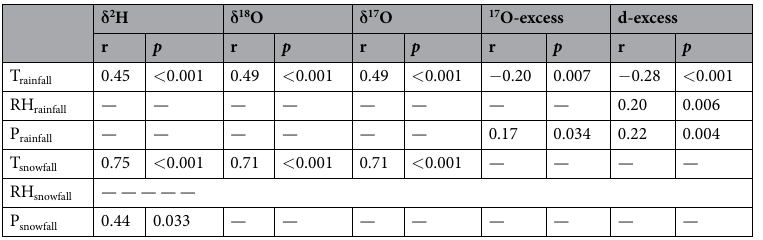
Table 5. The relationships between the precipitation isotopes ( δ 2 H/ δ 18 O/ δ 17 O), 17 O-excess, d-excess and local meteorological parameters (temperature (T), relative humidity (RH) and precipitation amount (P)) for rainfall and snowfall over the study period. “ − ” indicates the insignificant